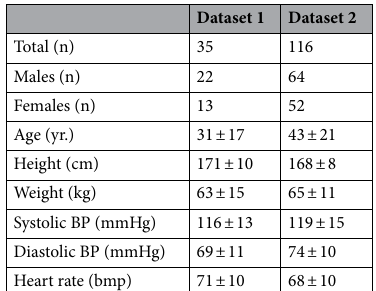
Table 1. Demographics of the volunteers for the dataset of 35 and 116, data are presented in mean ±